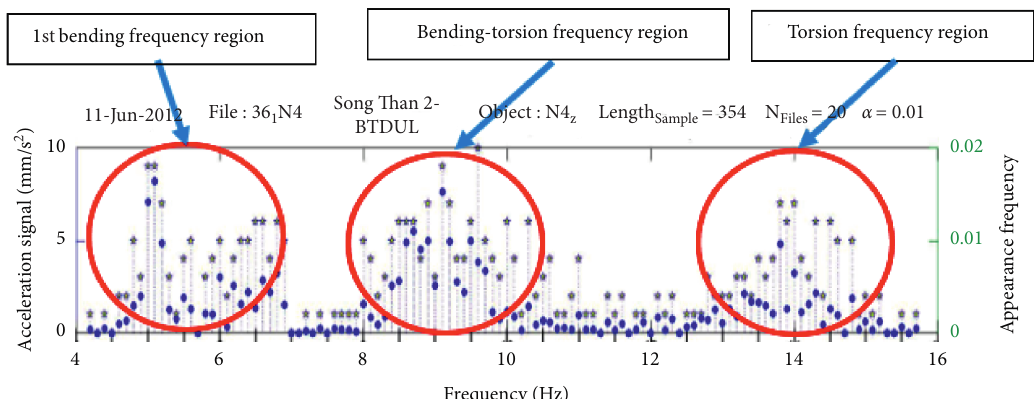
Figure 20: The representative power spectral density of Song Than 2 bridge.